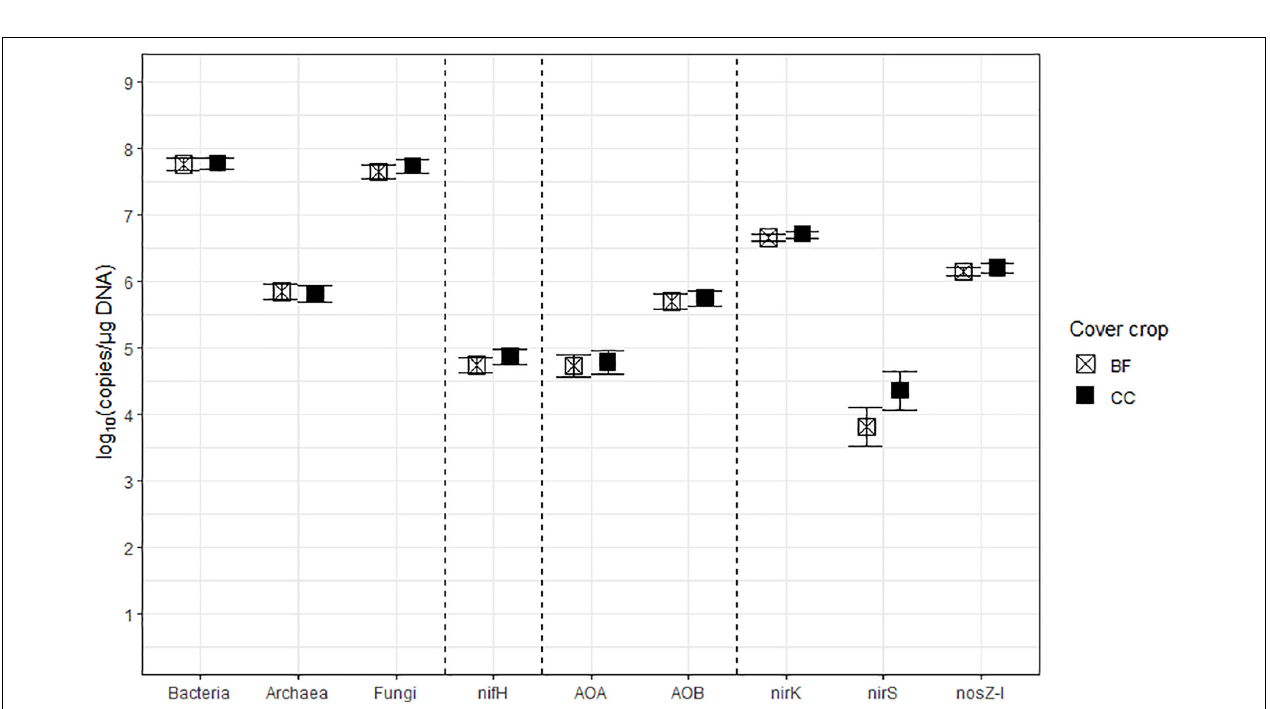
FIGURE 3 | The treatment means of soil microbial marker genes in log 10 (copies/ µ g DNA), including bacterial (Bacteria) and archaeal (Archaea) 16S rRNA, fungal ITS region (Fungi), nifH , archaeal (AOA) and bacterial (AOB) amoA , nirK , nirS , and nosZ-I separated by cover cropping (CC), with their standard errors of the mean as whiskers. The CC treatment levels were bare fallow control (BF) and hairy vetch and cereal rye cover crop mixture (CC).